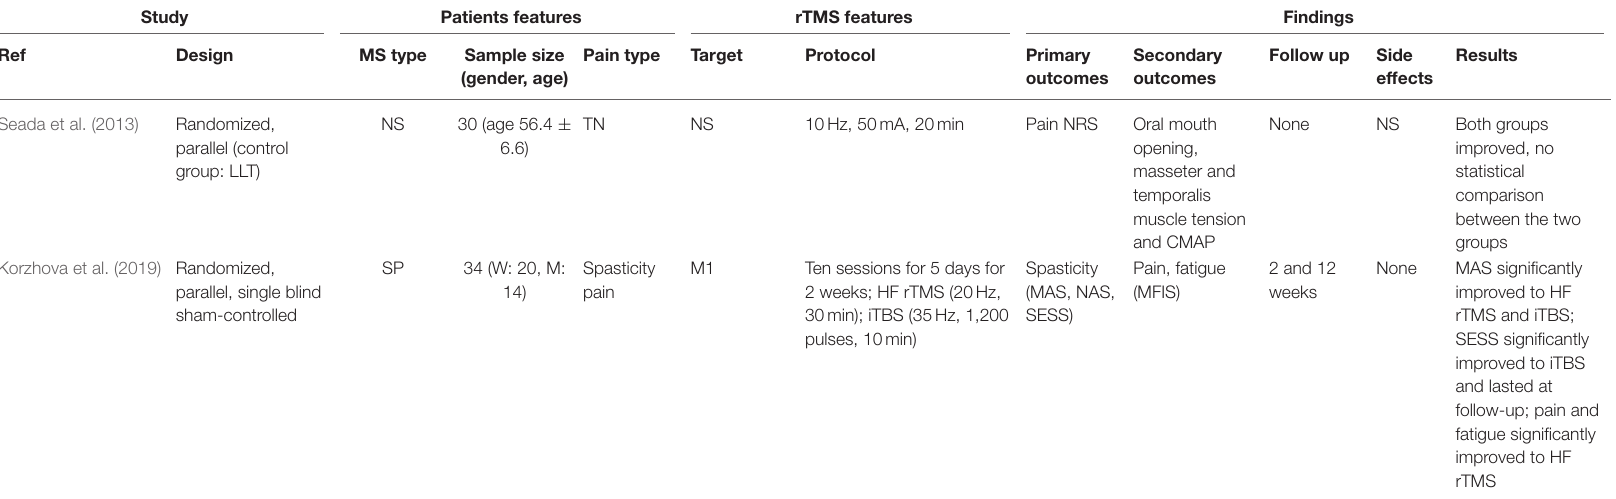
TABLE 2 | Overview of the rTMS studies included in the